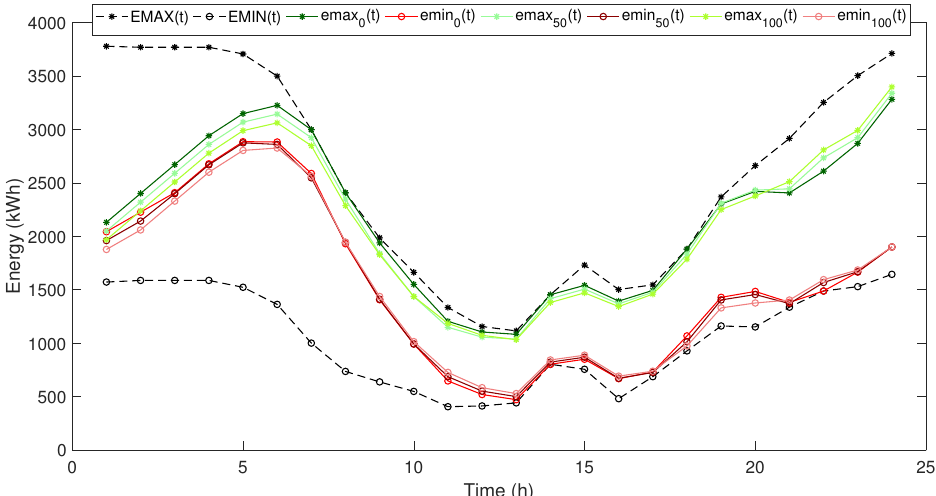
Figure 8. Evolution of bounding variables e min uncertainty ( Γ